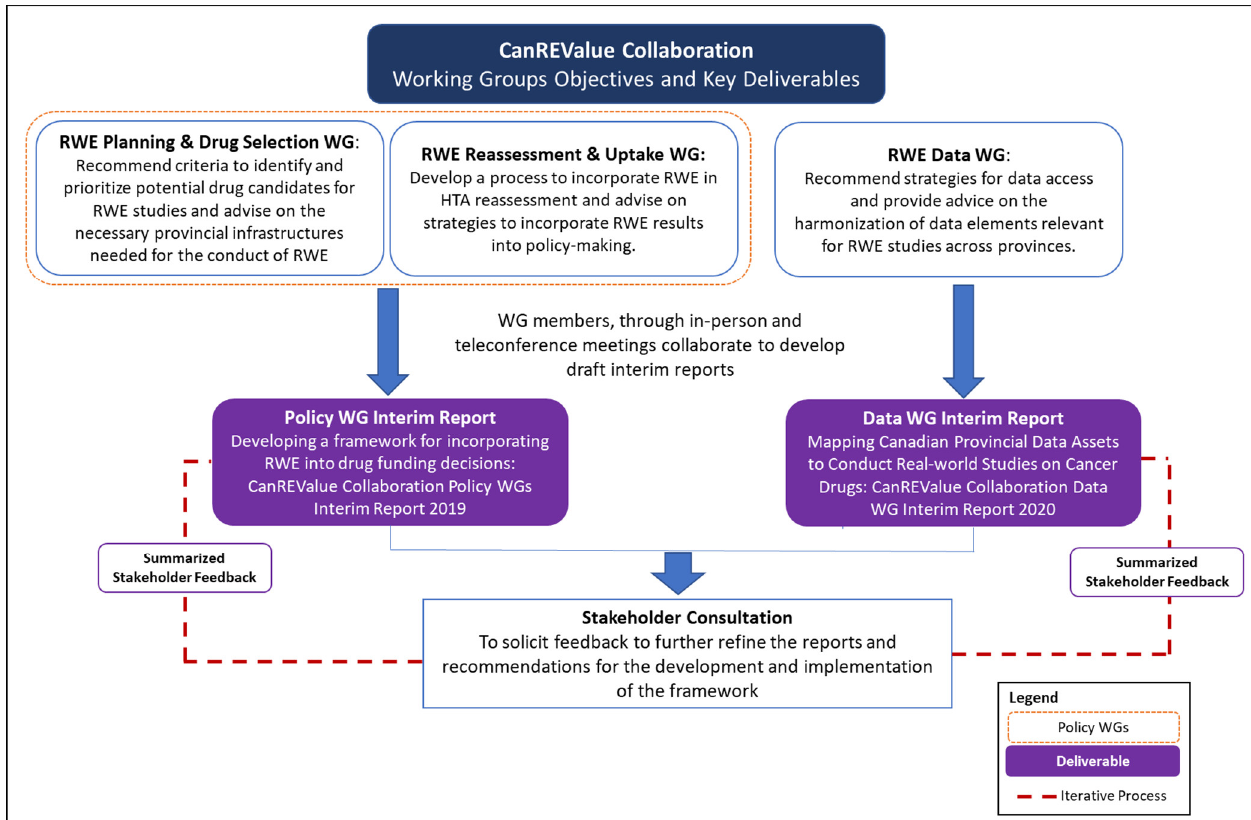
Figure 2. The CanREValue Policy and Data Working Group Interim Report Process.